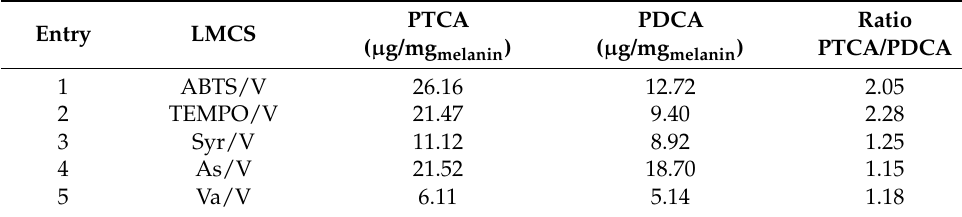
Table 3. Amount of PDCA and PTCA recovered after treatment of eumelanin with